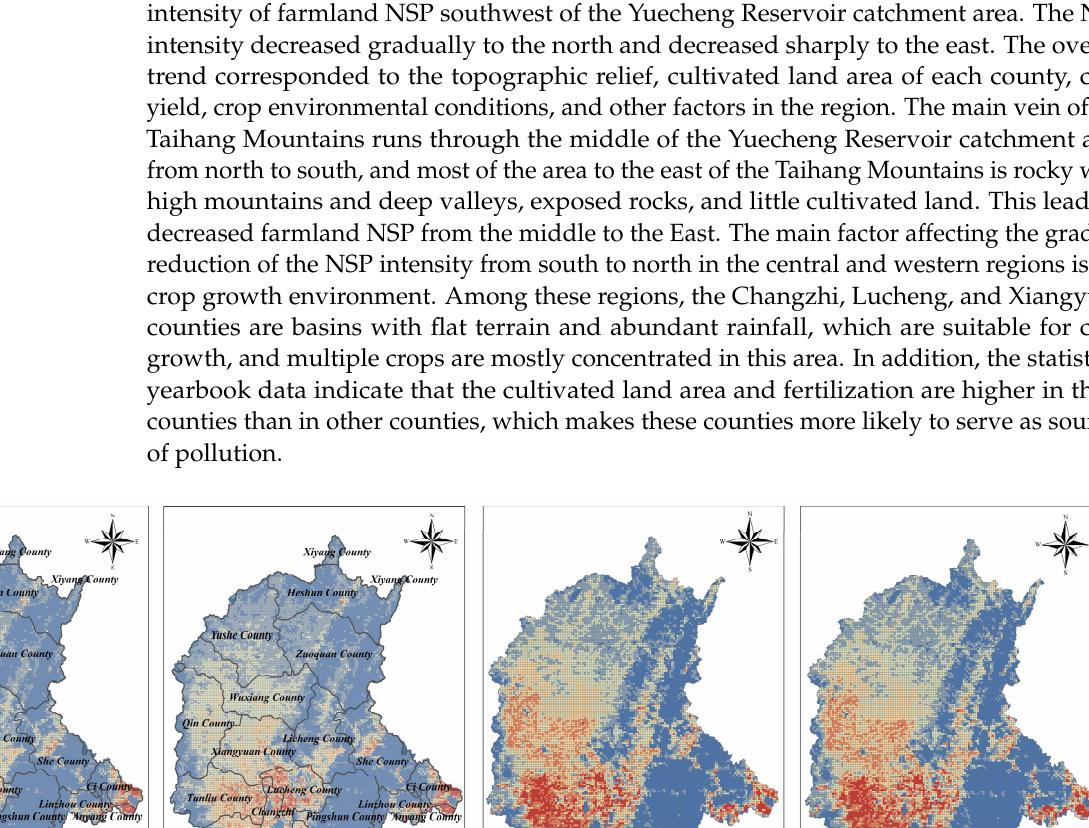
Figure 12. ( a ) Distribution map of NSP intensity estimated by the proposed method. ( b ) Distribution map of NSP intensity estimated by the traditional method.